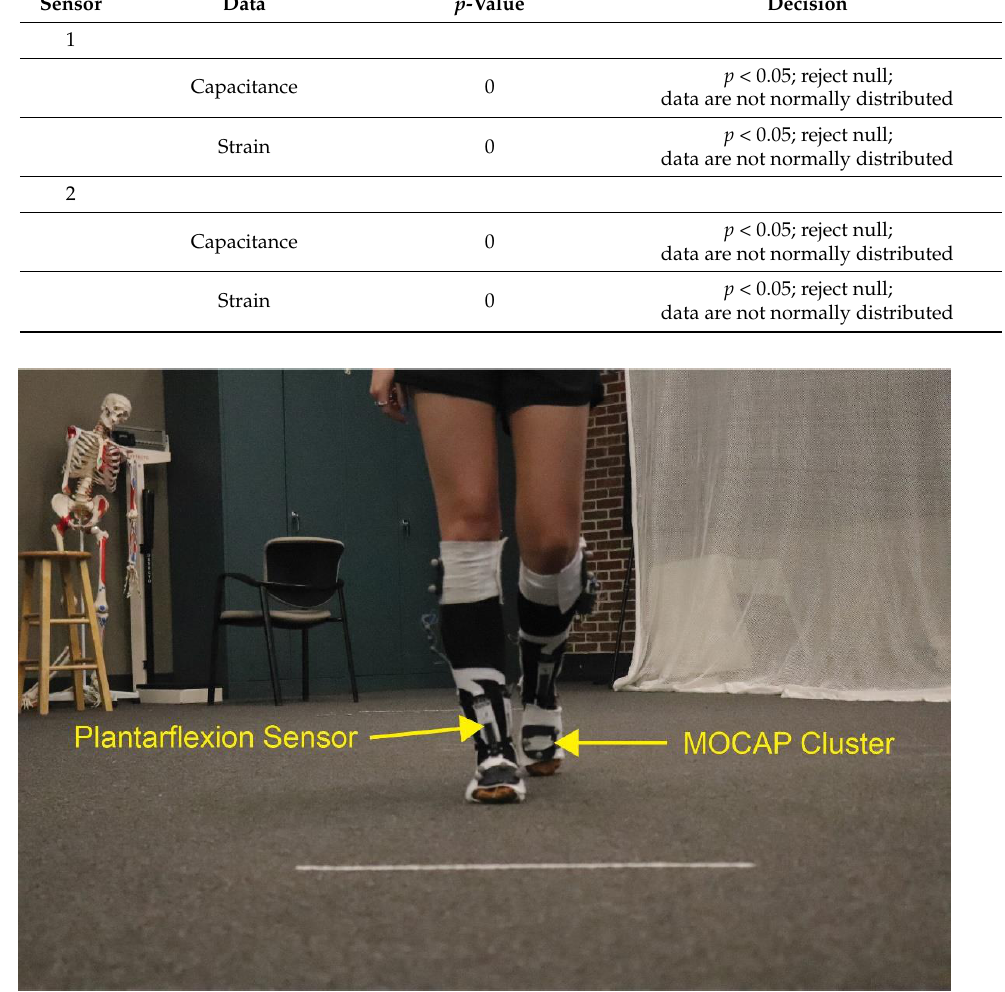
Figure 5. Example of the smart sock prototype in use during a gait trial.